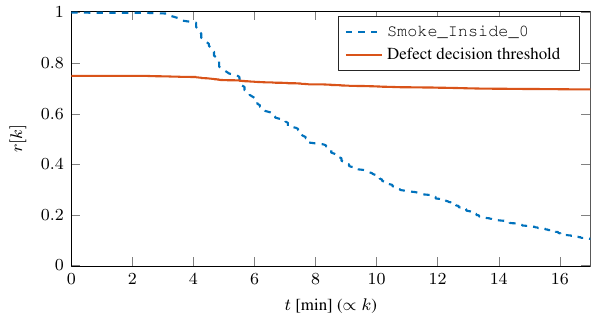
Figure 8. The defect decision threshold ( η = 0 . 75) and the reliabil- ity r [ k ] of the defective sensor Smoke_Inside_0 ( ω = 0 . 01).